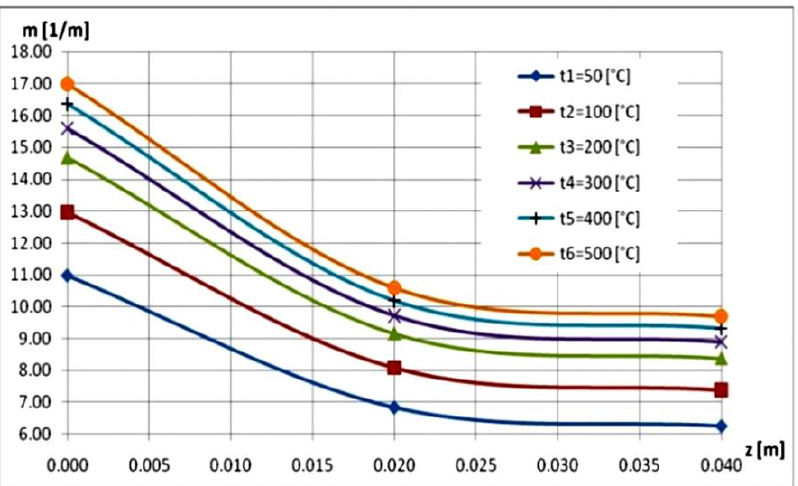
Figure 21. The variation in the parameter “ m ” for the whole length of the bar (cid:96) = z = 0.40 m , to α g = 180 ◦ .